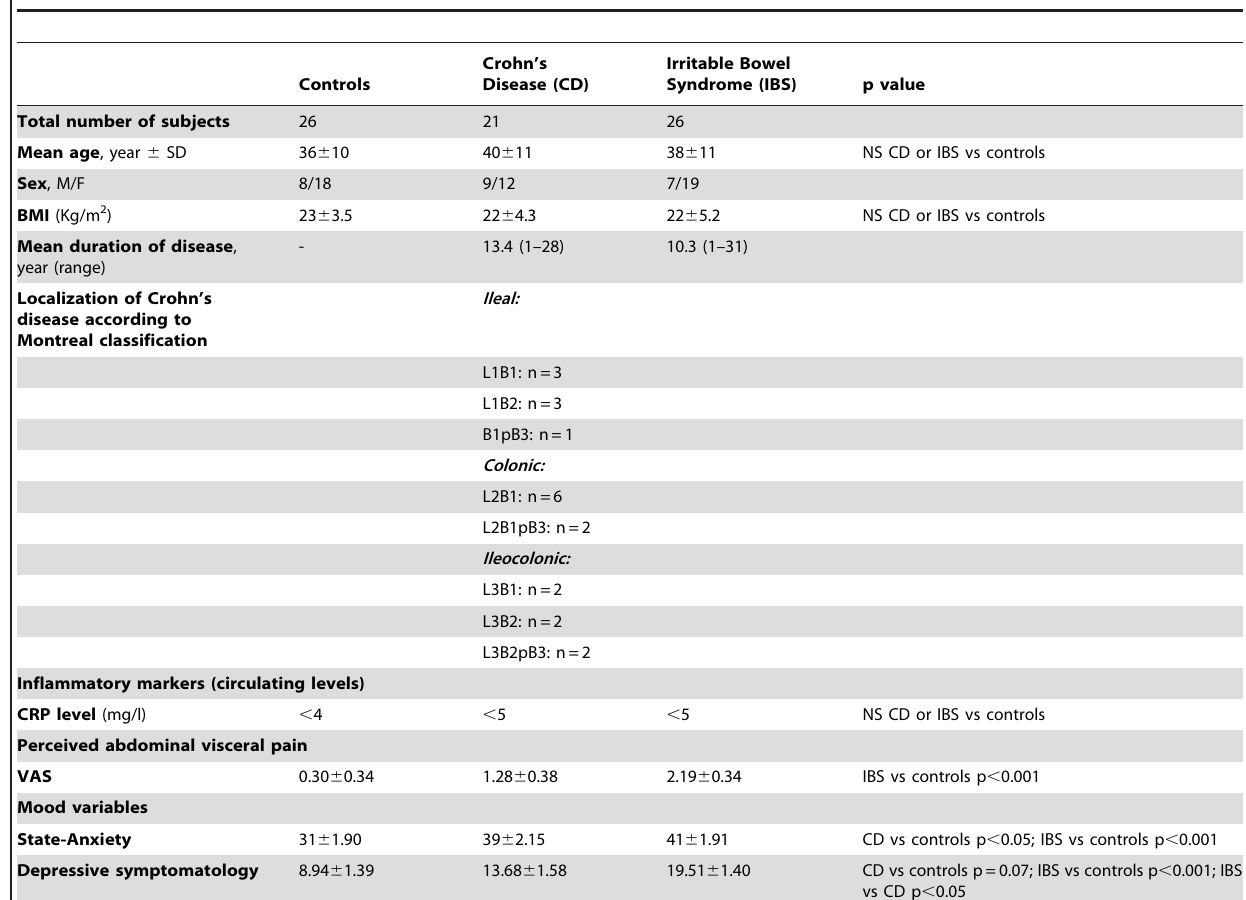
Table 1. Socio-demographic and psycho-immunologic data of the healthy control subjects, Crohn’s disease (CD) and irritable bowel syndrome (IBS) patients who participated to the